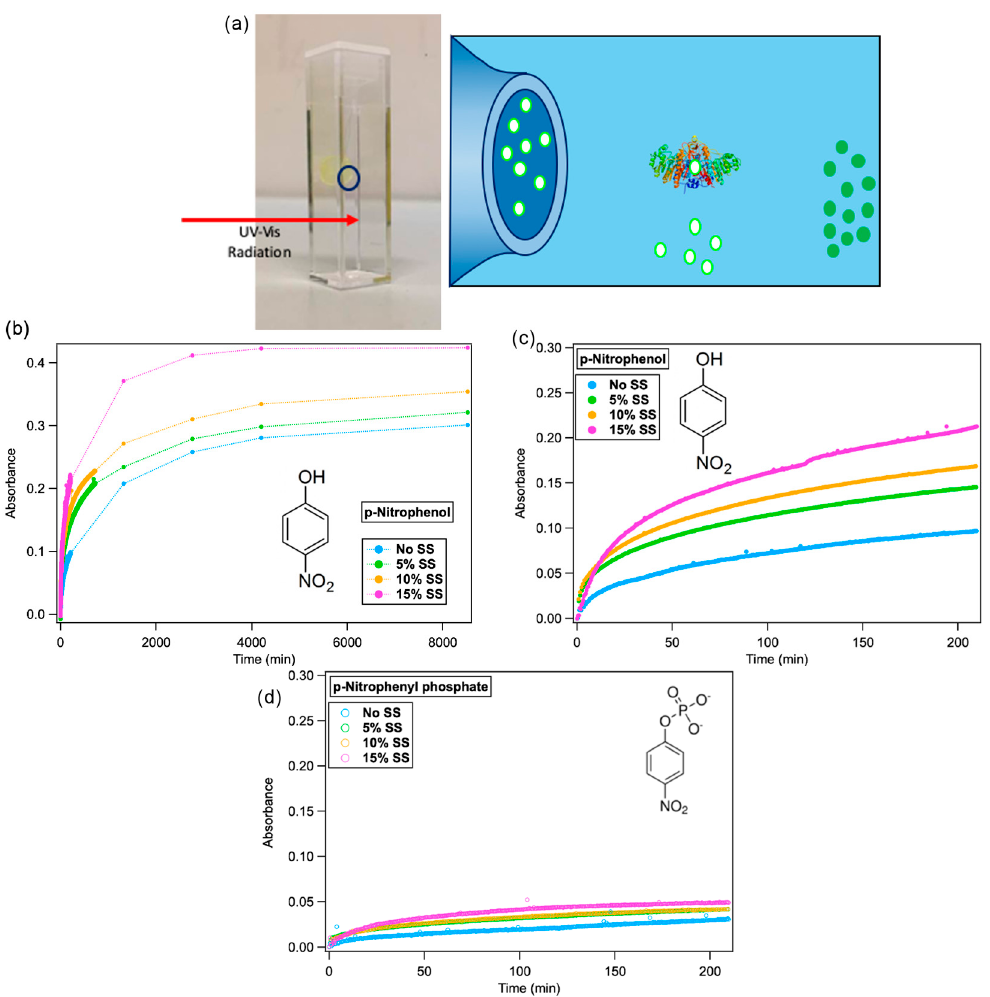
Figure 3. Reaction kinetics with the substrate confined in liquid crystalline mesophases. ( a ) Sketch of the experiment of AP-catalysed reaction with the substrate confined in the cubic mesophase; ( b , c ) UV–vis absorbance of p-nitrophenol in solution, recorded at 400 nm for 4 h ( b ) and six days ( c ); ( d ) UV–vis absorbance of p-nitrophenylphosphate in solution, recorder at 310 nm for 4 h. The di ff erent curves are related to experiments performed with the substrate confined in the di ff erent mesophases: No SS (cyan markers), 5% SS (green markers), 10% SS (orange markers) and 15% (purple markers).